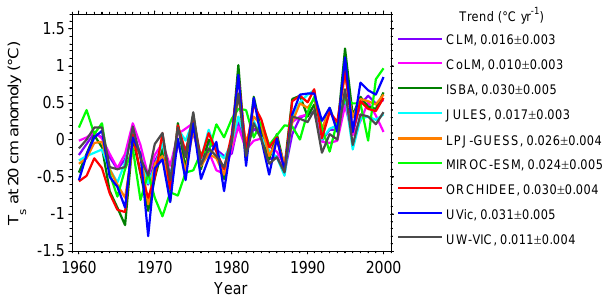
Figure 2. Simulated anomaly of annual T s at 20cm averaged over boreal regions of each model, during the period of 1960–2000.